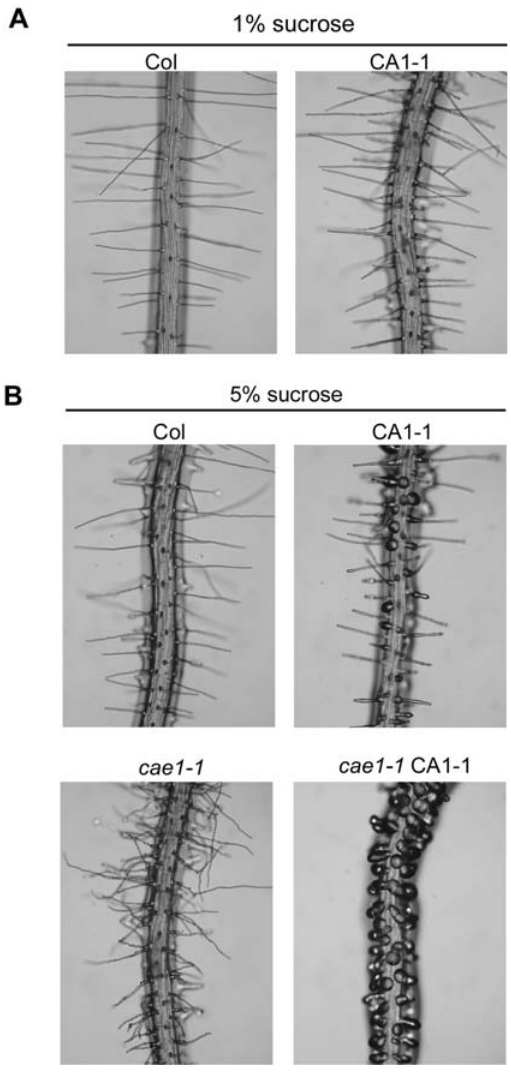
Figure 1. Isolation of a CA1-1 enhancer (cae1-1) in root hair tip growth. (A) Col and CA1-1 root hairs grown in the presence of 1% sucrose. (B) Root hairs grown in the presence of 5% sucrose. CA1-1 showed some bulbous root hairs, however all of root hairs in the CA- rop2 enhancer mutant ( cae1-1 CA1-1) were bulbous. In the Col background, cae1-1 caused root hairs waving and branching.